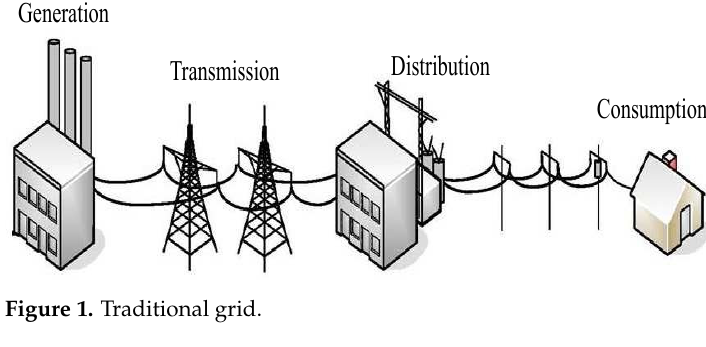
Figure 1. Traditional grid.